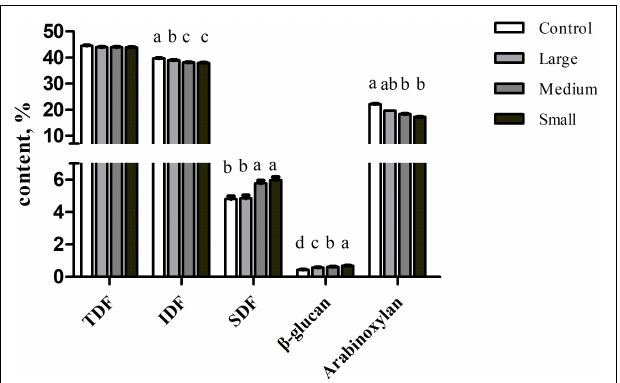
FIGURE 1 | Contents of TDF, SDF, IDF, β -glucan, and arabinoxylan of wheat bran with different particle sizes, %. Data are shown as mean ± SEM ( n = 4); a − d represents significant difference among different treatments ( p < 0.05); Control, no ground wheat bran; Large, wheat bran ground through a 2.0-mm sieve; Medium, wheat bran ground through a 1.5-mm sieve; Small,